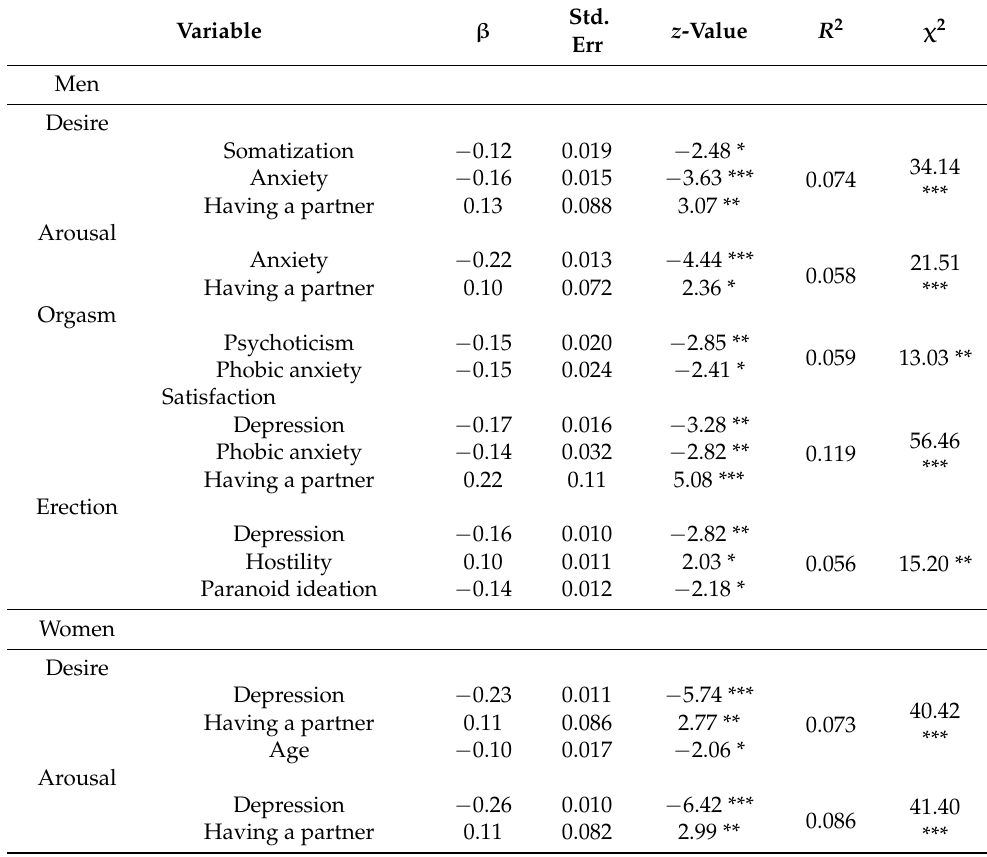
Table 4. Hierarchical linear regression analysis of the dimensions of sexual functioning and of the explanatory role of psychopathological dimensions and sociodemographic characteristics in men and